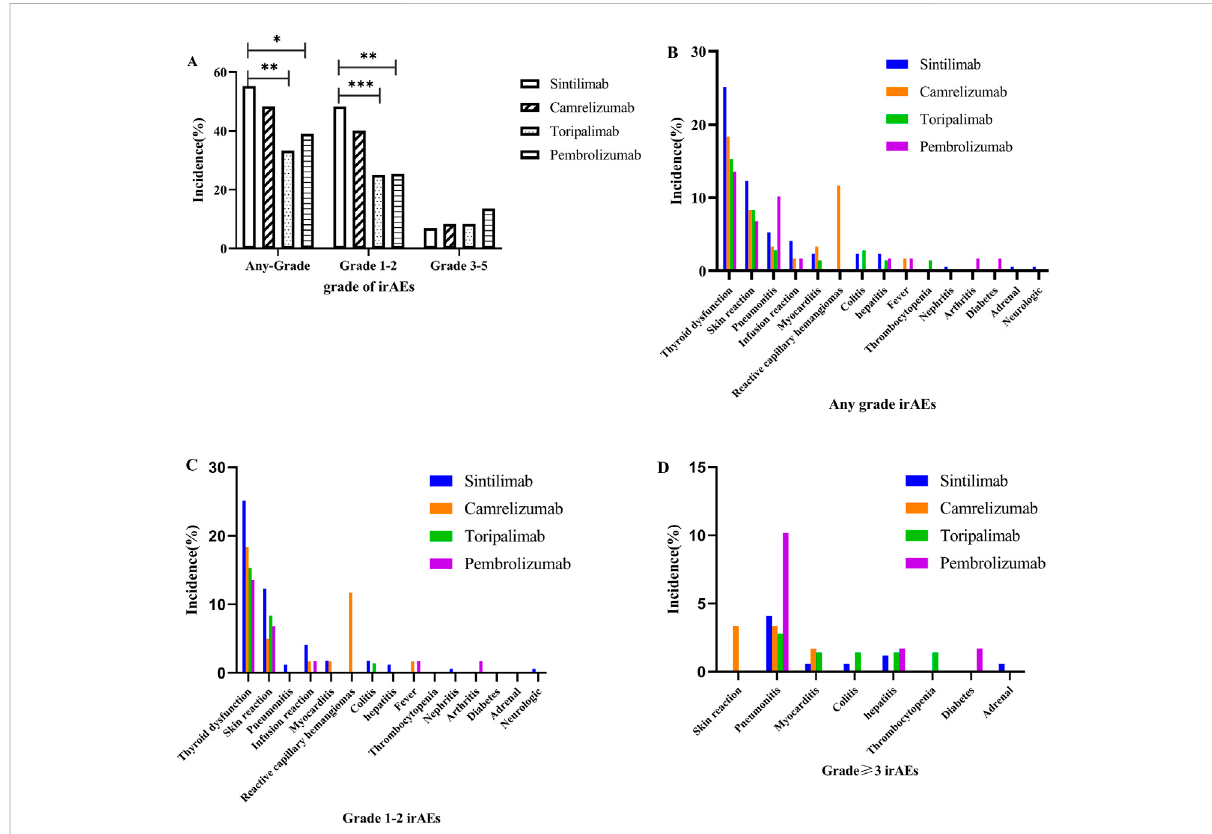
FIGURE 2 Immune-related adverse events between different immune checkpoint inhibitors: (A) any irAEs; (B) any grade; (C) grade 1 – 2; (D) grade ≥ 3.